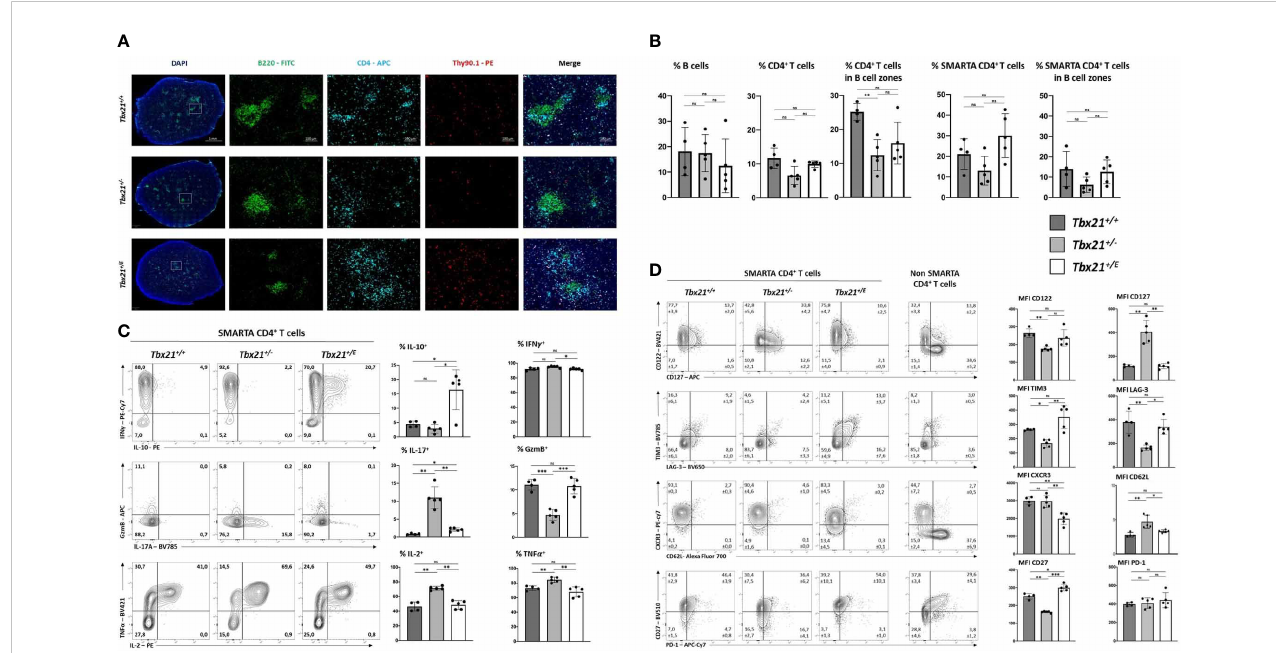
FIGURE 3 Eomes induces IL-10 production in CD4 + T cells but does not alter migration in spleen during acute infection. 2x10 4 SMARTA CD4 + T cells were transferred into C57BL/6 mice, following LCMV infection as shown in Figure 2A. (A) Immuno fl uorescence staining with indicated antibodies and DAPI. An overview and single staining for representative B cell zones are shown. (B) Relative cell numbers were calculated by computational marking and counting of cells in the total spleen and in marked B cell zones. (C) Intracellular staining of cytokines was performed after 4 hours of stimulation with PMA, Ionomycin and Brefeldin (A) Representative dot plots and the MFI in bar diagrams are shown. (D) Surface staining of indicated markers shown in dot blots and MFI in bar diagrams. SMARTA CD4 + T cells were identi fi ed as CD4 + CD90.1 + . Endogenous non-SMARTA CD4 + T cells (CD4 + CD90.1 - ) were used as a staining control and for setting quadrant gates in (C, D) . Statistical analysis: *=p < 0.05; **=p < 0.01; ***=p < 0.001; ns, not signi fi cant; Error bars denote mean + SEM. n=2 with 4-5 mice per